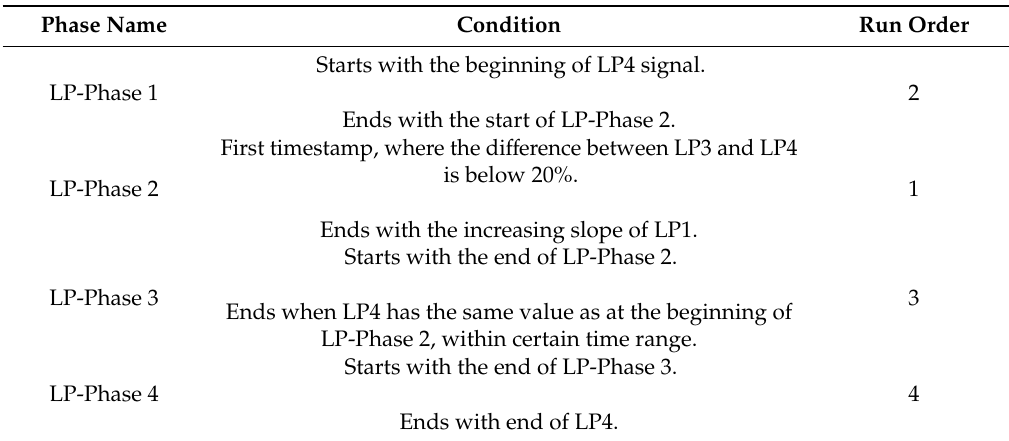
Figure 6. Example results for lot #2 of the intertwined phase setting method. The LP-Phases 1–4 are shown as filled rectangles in different grey colors. The normalized signal of LP3 is shown in orange, the normalized signal of LP4 is shown in green and the normalized signal of LP1 is shown in red. For this approach the LP1, LP3 and LP4 signal (LP—lyophilization) were used. The detailed phase-setting conditions for this algorithm are described in Table 2. Table 2. Condition description on how the four phases LP-Phase 1-4 were set. The phases were set accordingly to the “run order”.